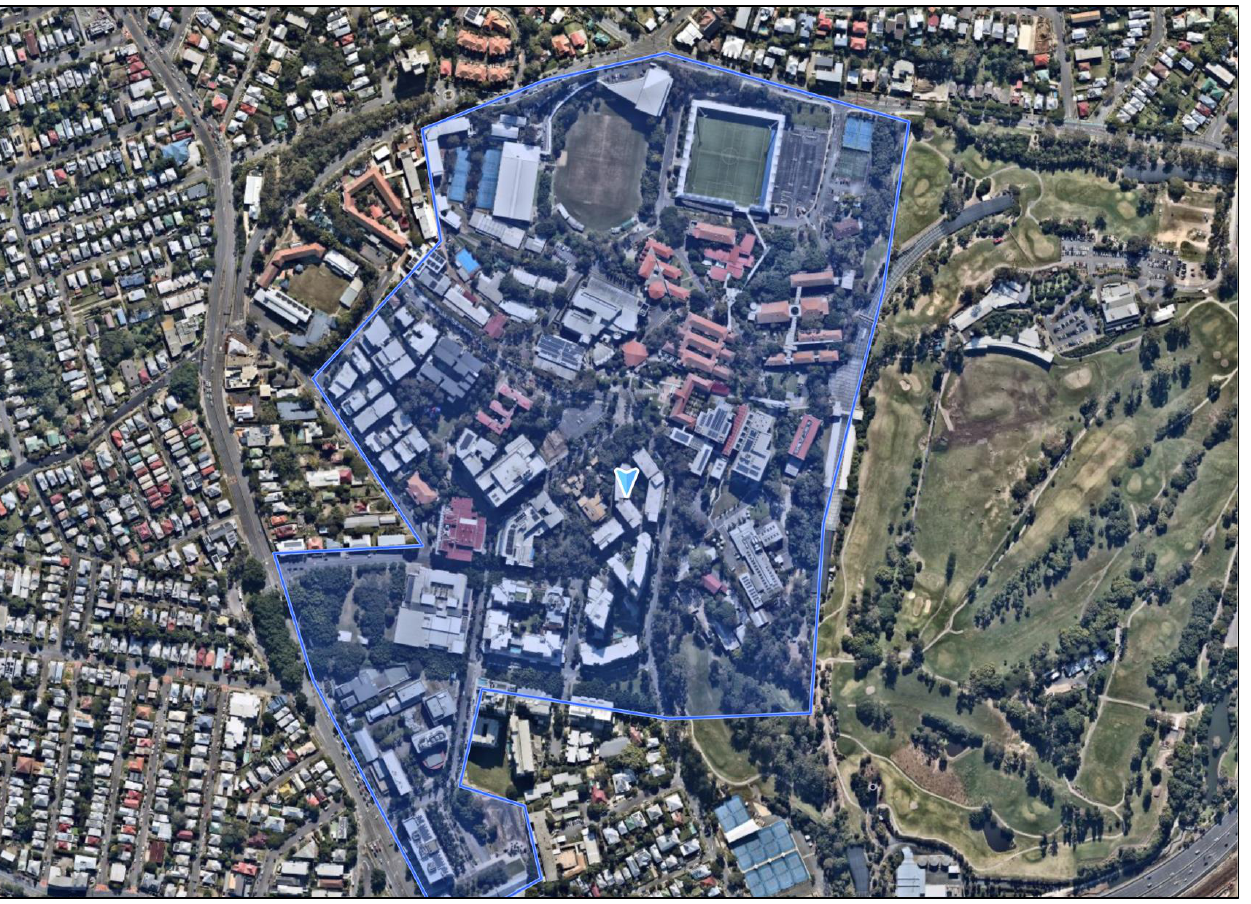
Figure 4. Location of Kelvin Grove Urban Village.